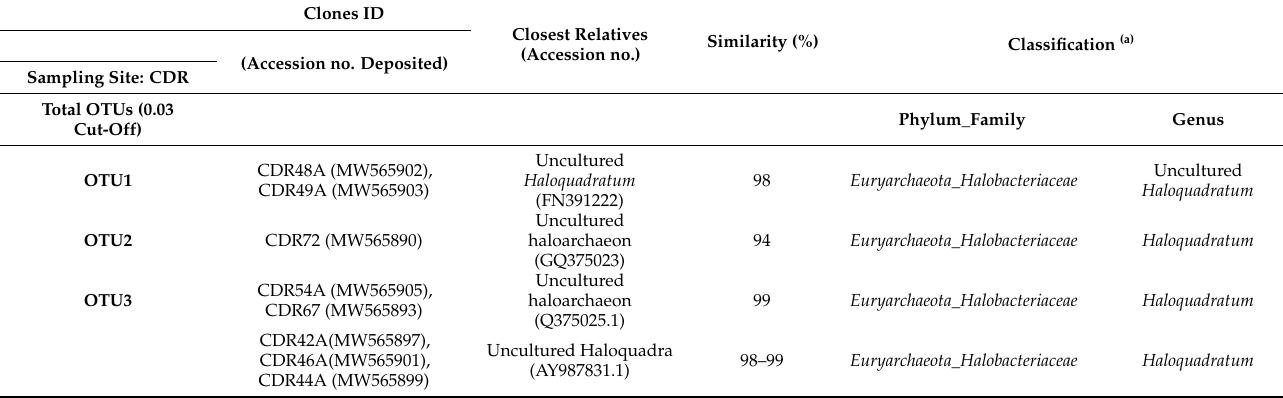
Classification (a)